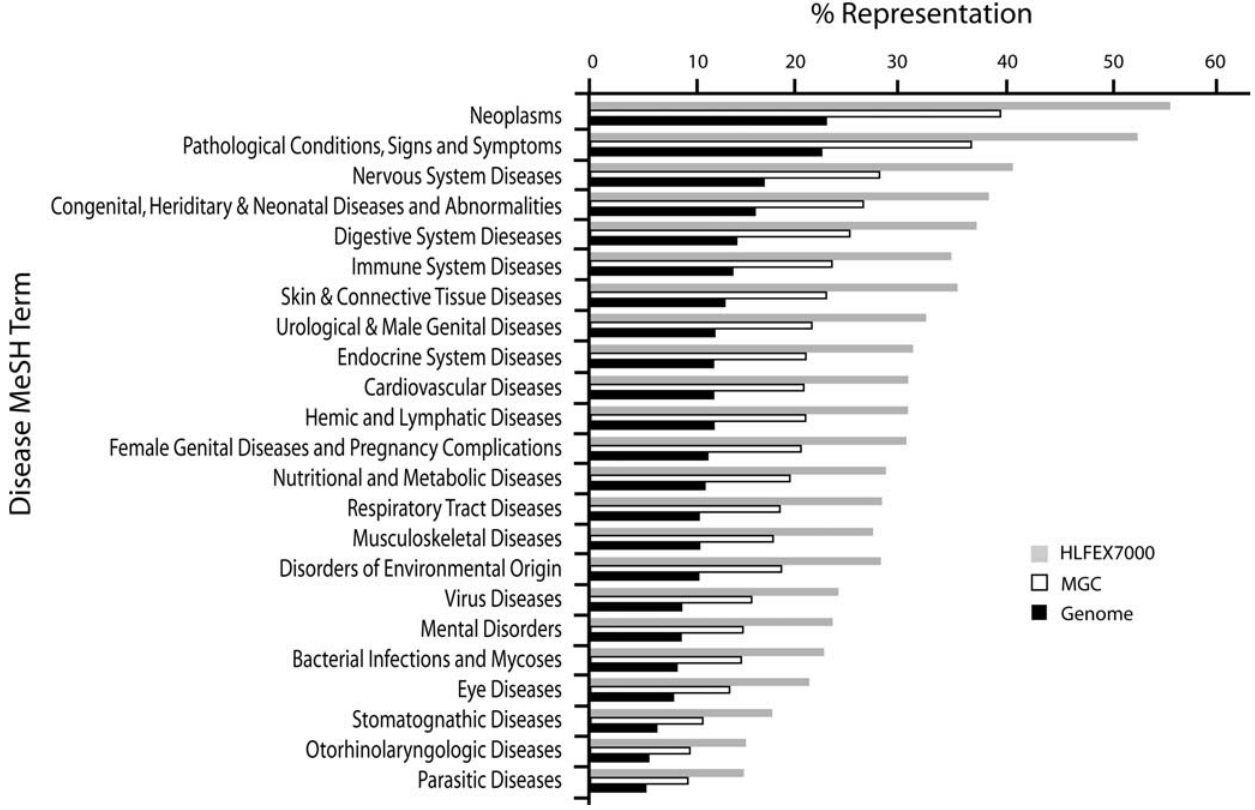
Figure 1. Genes associated with Disease Classes (MeSH) in Publications. The clone target list (HFLEX7000) was compared with all human genes (EntrezGene, 2004) and all genes represented by MGC (2004) with respect to published relationships of the genes to human diseases. The targeted genes reveal similar proportionality to the other gene lists but a general enrichment of genes related to diseases (Table 1; Supplementary Table S2).